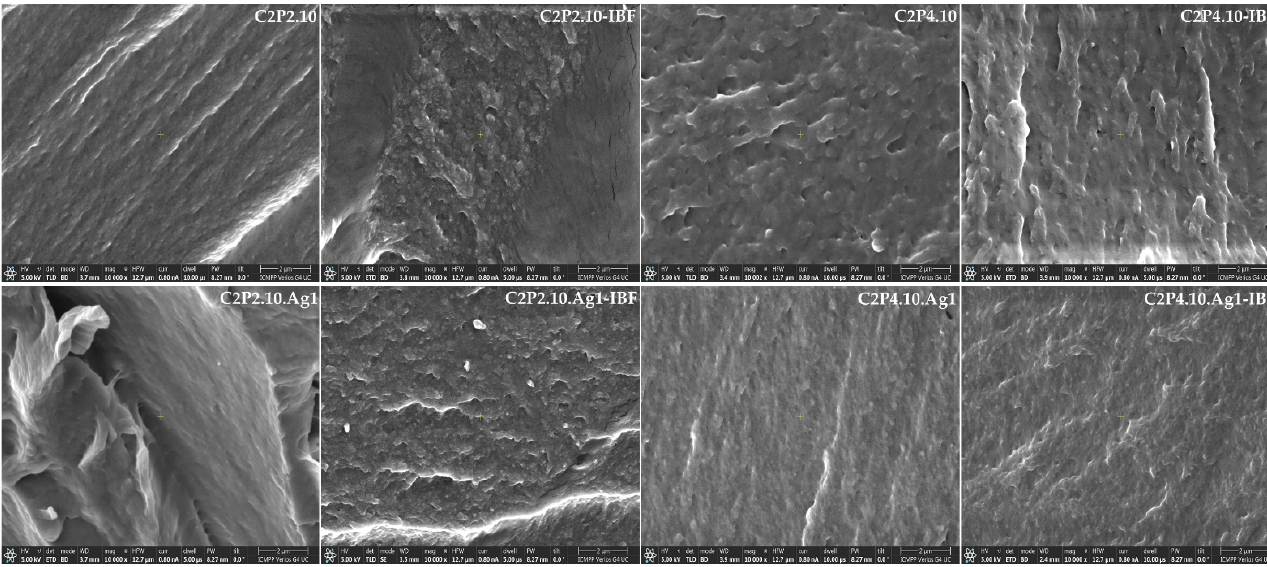
Figure 5. SEM micrographs in cross section of the obtained